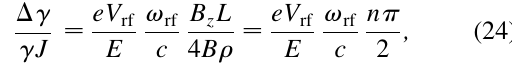
parameters give a conditioning of roughly 1 : 6 (cid:13)